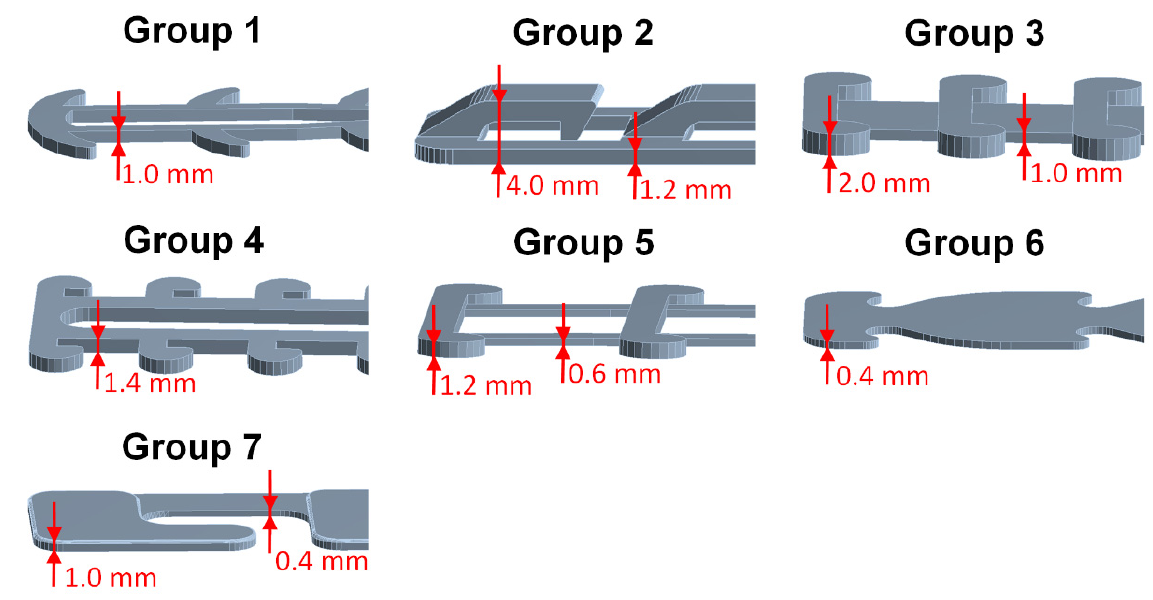
Figure 2. The relevant thicknesses of the SMTRB models for each group.